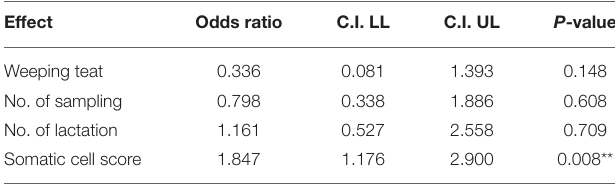
TABLE 6 | Results of the linear general mix model on herd A sampled in 2018 and 2019 on fixed effects in Model 2. Effect Odds ratio